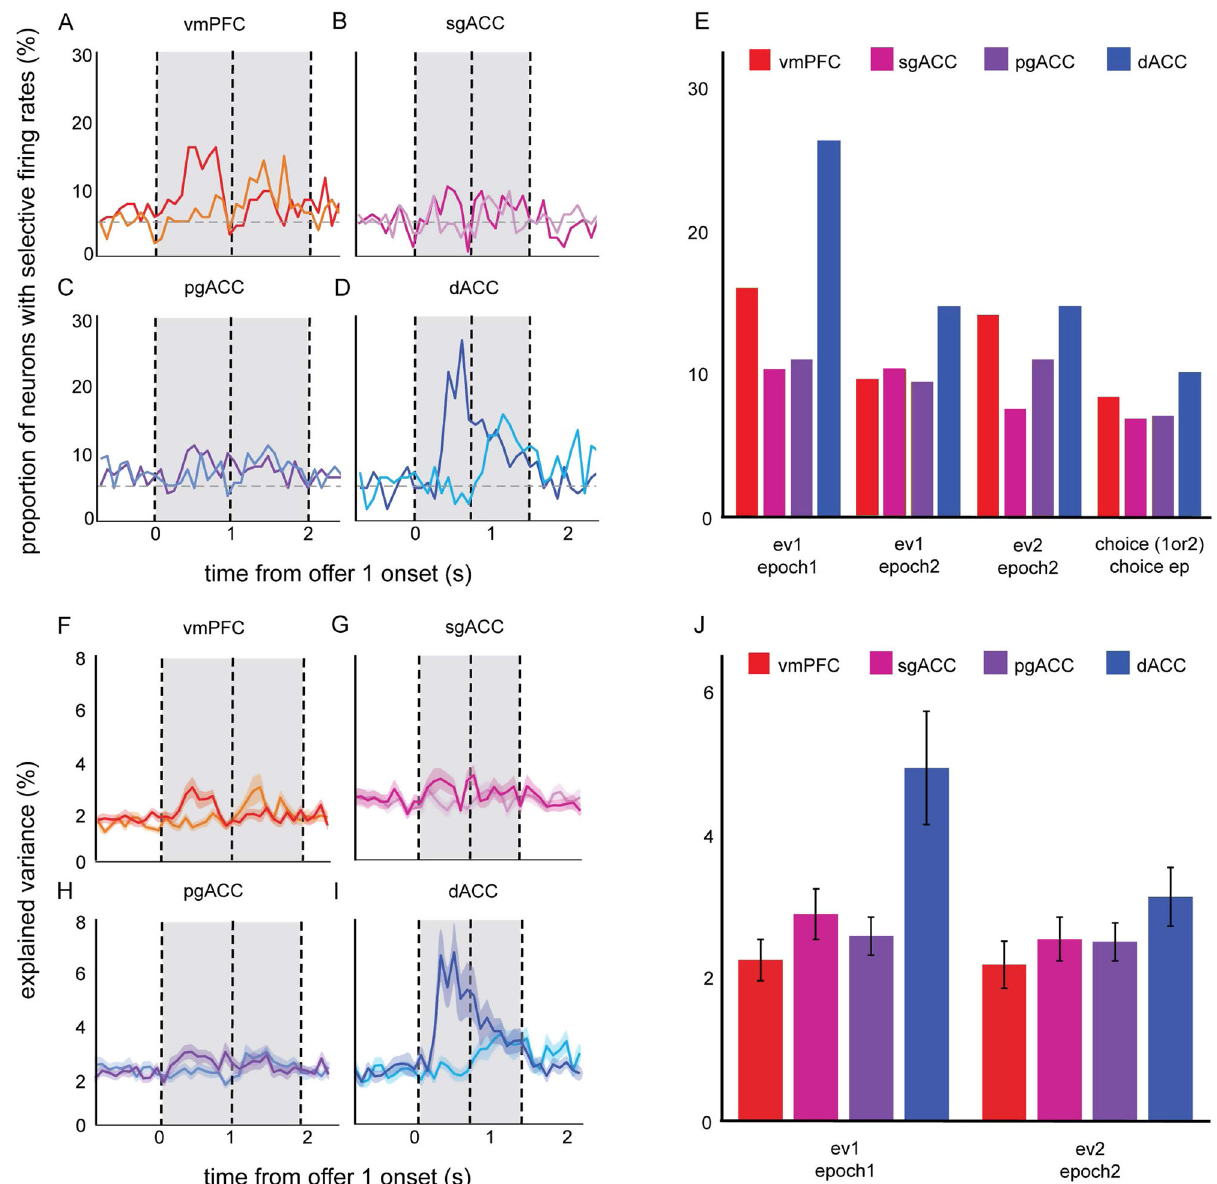
Fig. 3 Selectivity of fi ring rates to offers and choice. A – D The proportion of neurons that have fi ring rates that are correlated with the expected value of offer 1 (darker color) and offer 2 (lighter color) across a 3-s period during the trial (red = vmPFC, pink = sgACC, purple = pgACC, blue = dACC). The onset of offer 1 is set to time 0. The vertical lines indicate the onsets of offer 1 and offer 2. Source data are provided as a Source Data fi le. E A summary of the proportion of neurons selective to offers and choice, within given epochs. Each bar indicates the proportion within a given brain area. Source data are provided as a Source Data fi le. F – I The average variance explained ( r 2 ) across neurons, from correlating fi ring rates with the expected values of offer 1 (darker color) and offer 2 (lighter color). Each trace (a measure of center) indicates the average explained variance across neurons. Vertical lines and shading on the x -axis indicate trial events. Error ribbons denote standard error. Source data are provided as a Source Data fi le. J A summary of average explained variance, collapsed across the respective offer epoch (500ms window), relative to each of the offers (vmPFC: n = 156 neurons; sgACC: n = 146 neurons; pgACC: n = 213 neurons; dACC: n = 129 neurons). Error bars denote the standard error across neurons. Source data are provided as a Source Data fi